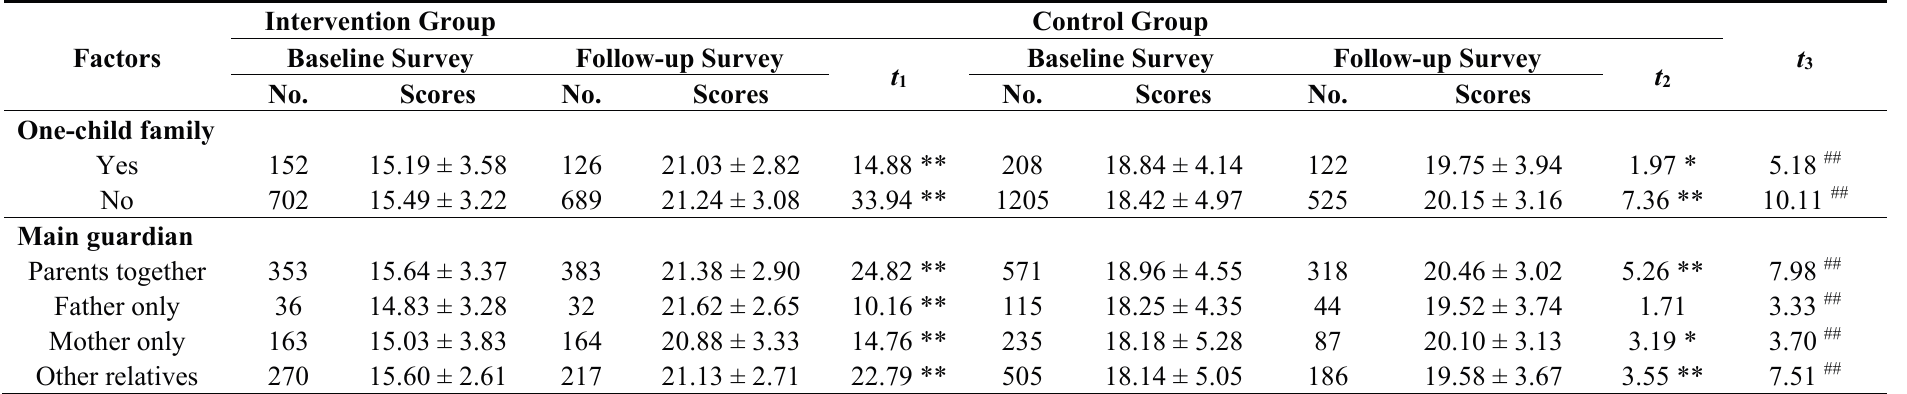
Table 2. Knowledge and attitude scores (KAS) for children from different family environments in the intervention and control groups at baseline and